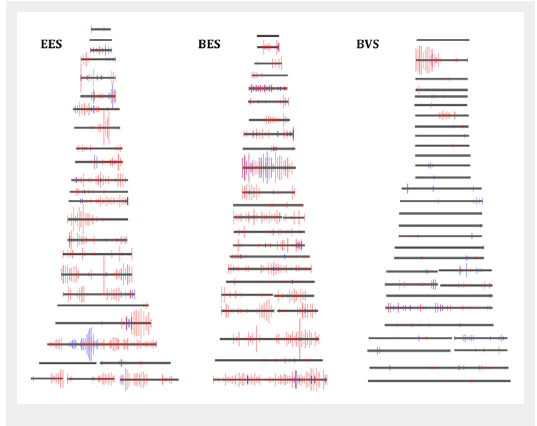
Graphical representation of strut coverage and malapposition in lesions. Lesions = horizontal gray bars, uncovered struts = red lines, malapposed struts = blue lines, according to geographical location on stent/scaffold. BES = biolimus-eluting stent; BVS = bioresorbable vascular